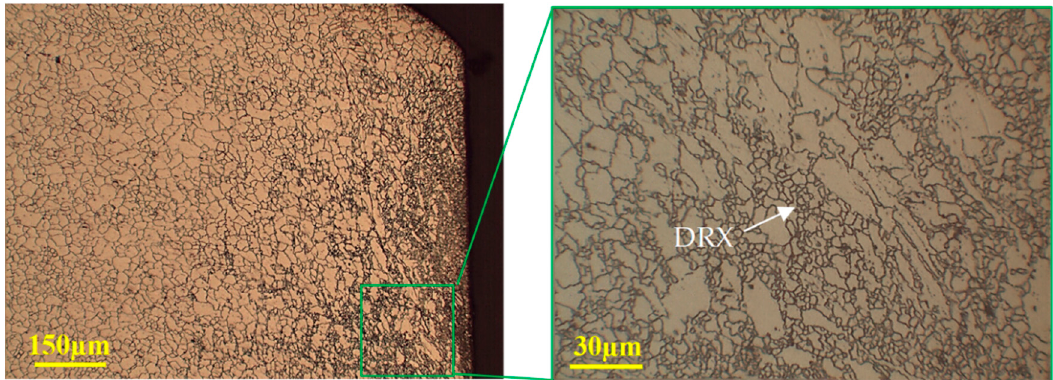
Figure 21. Optical microstructure of the shear zone at 250 °C and 20% clearance, illustrating